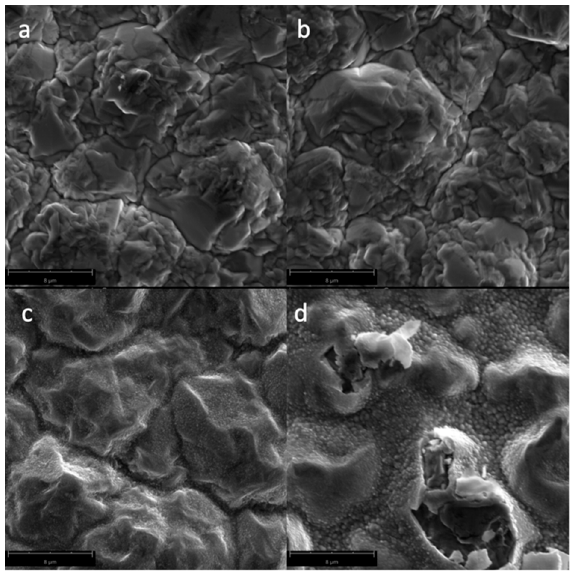
Figure 2. Scanning Electron Microscopy (SEM) micrographs of the surfaces of the Cu samples (magnified at 10,000×) subjected to oxygen plasma with varying powers: ( a ) untreated; ( b ) 100 W; ( c ) 300 W; and ( d ) 600 W.